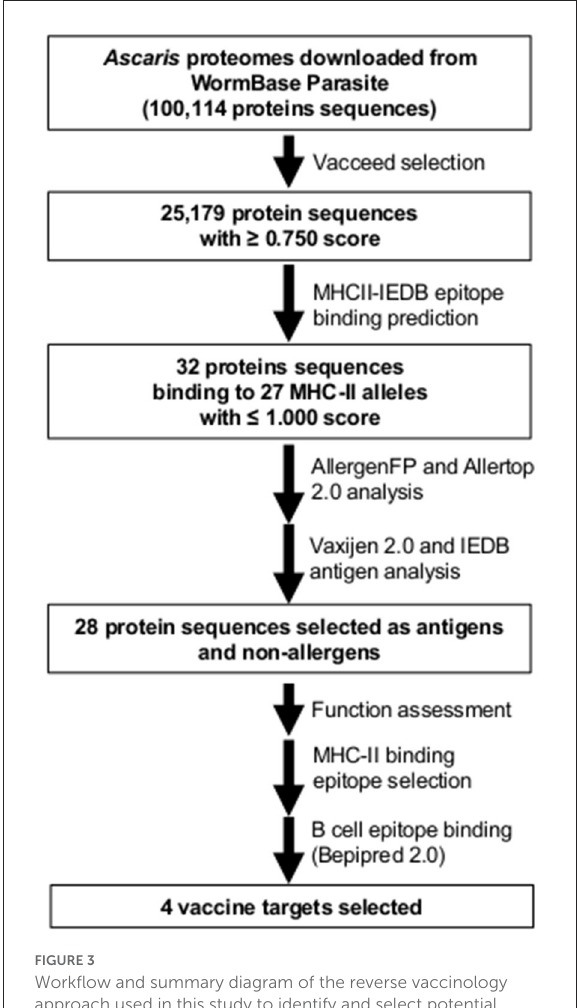
FIGURE3 Workflow and summary diagram of the reverse vaccinology approach used in this study to identify and select potential vaccine targets in Ascaris lumbricoides and A. suum